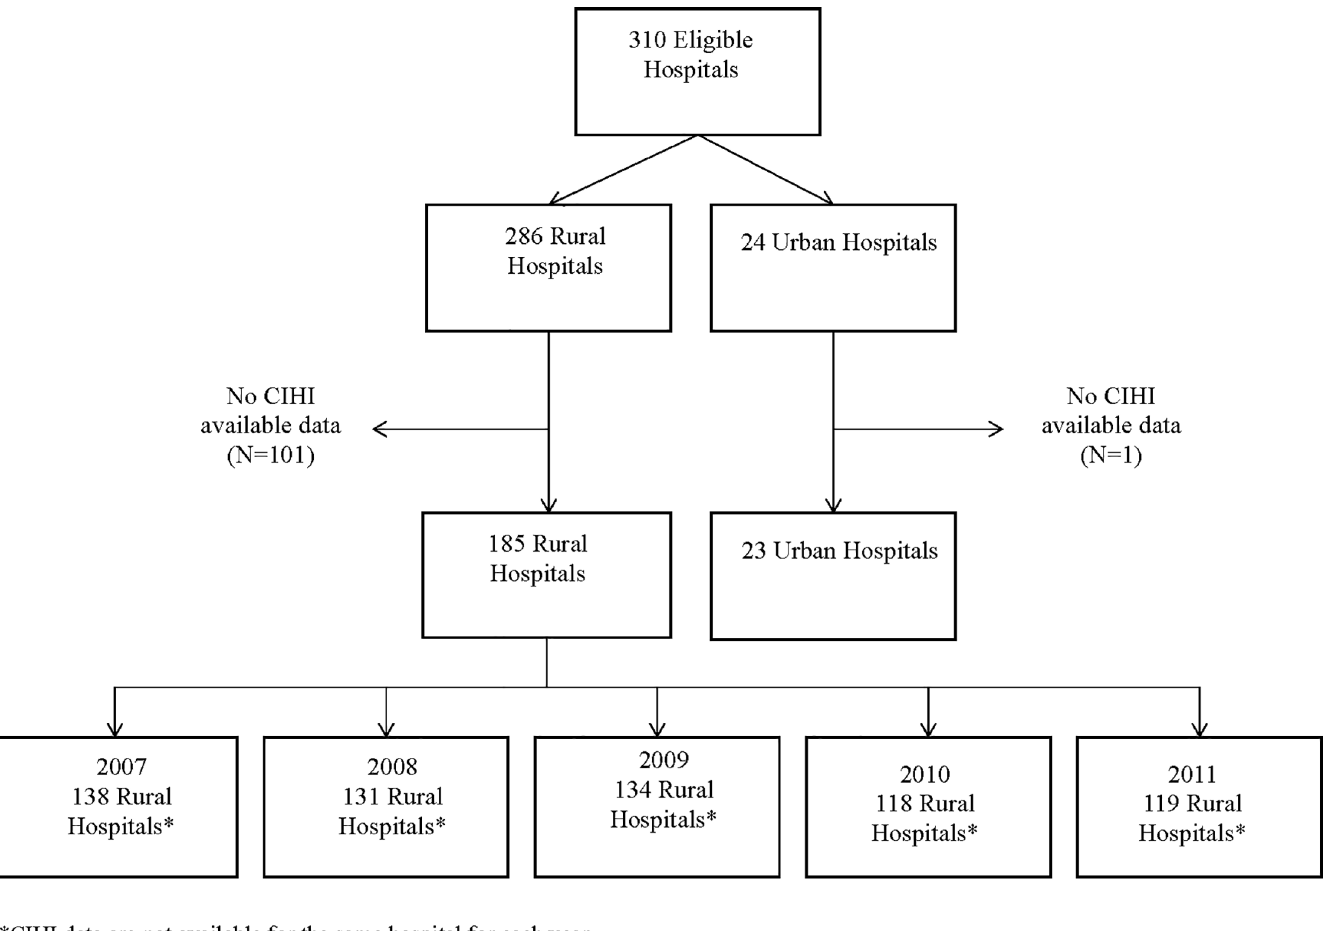
Fig 1. Flowchart of hospitals with CIHI available